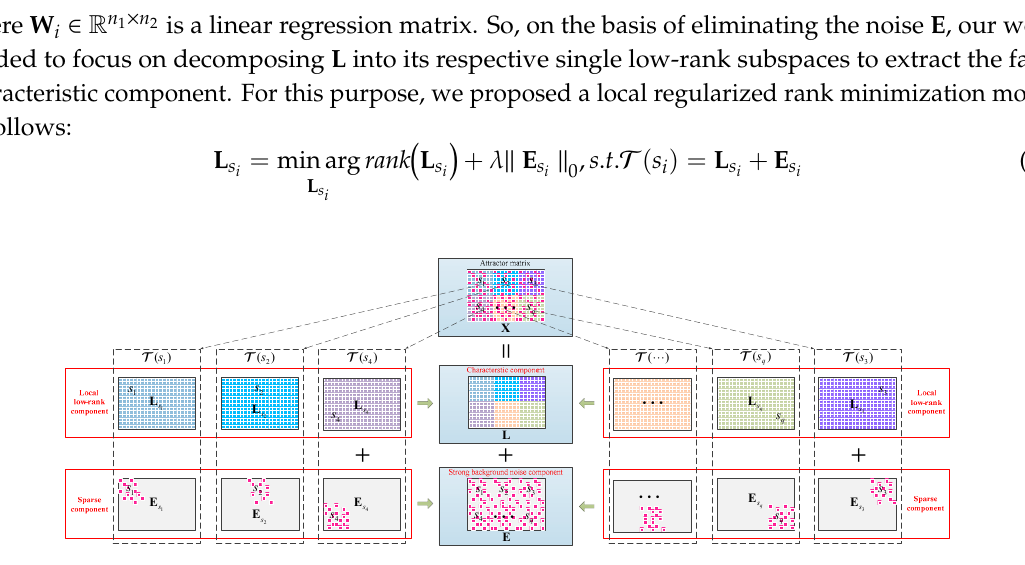
Figure 6. Illustration of the proposed signal decomposition method based on local low-rank matrix approximation (LLORMA).